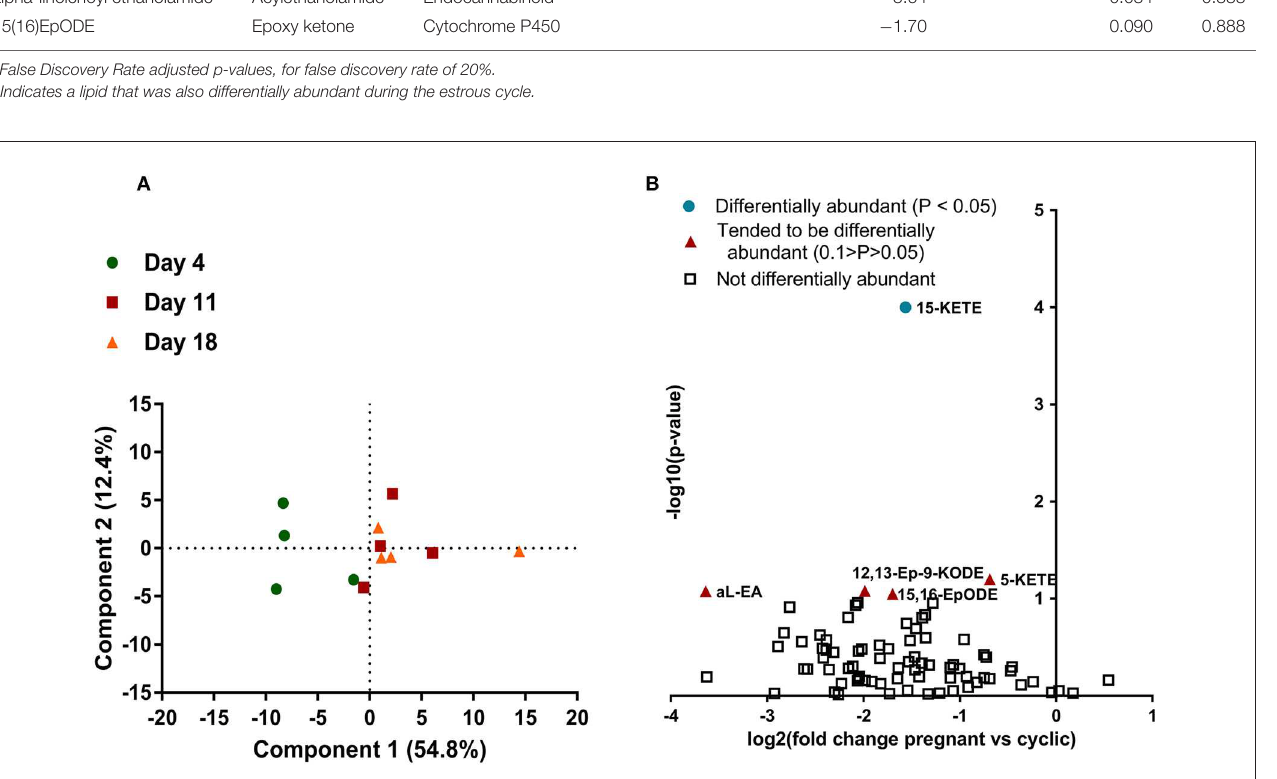
FIGURE 1 | Lipids in the CL during the estrous cycle and early pregnancy ( N = 4/group). (A) Principle component analysis, with each point representing one sample from the lipid profiling experiment. Samples from day 4 are represented with a green circle, samples from day 11 are represented with a red square, and samples from day 18 are represented by an orange triangle. Distance apart on principle components 1 and 2 is a proxy for overall similarity in lipid abundance profile, with closer points being more alike. (B) Volcano plot of all lipids measured in the CL on day 18 of the estrous cycle and pregnancy. Each lipid is represented by a point, with the lipids that did not change represented with an open square, the lipids that tended to change represented by an orange triangle, and the lipids that changed ( P < 0.05) represented by a teal circle. Magnitude of statistical significance is represented in the y-axis, while numerical fold change is represented on the x-axis, with lipids that were greater during the CL of the estrous cycle on the left and lipids that were greater in the CL of pregnancy on the